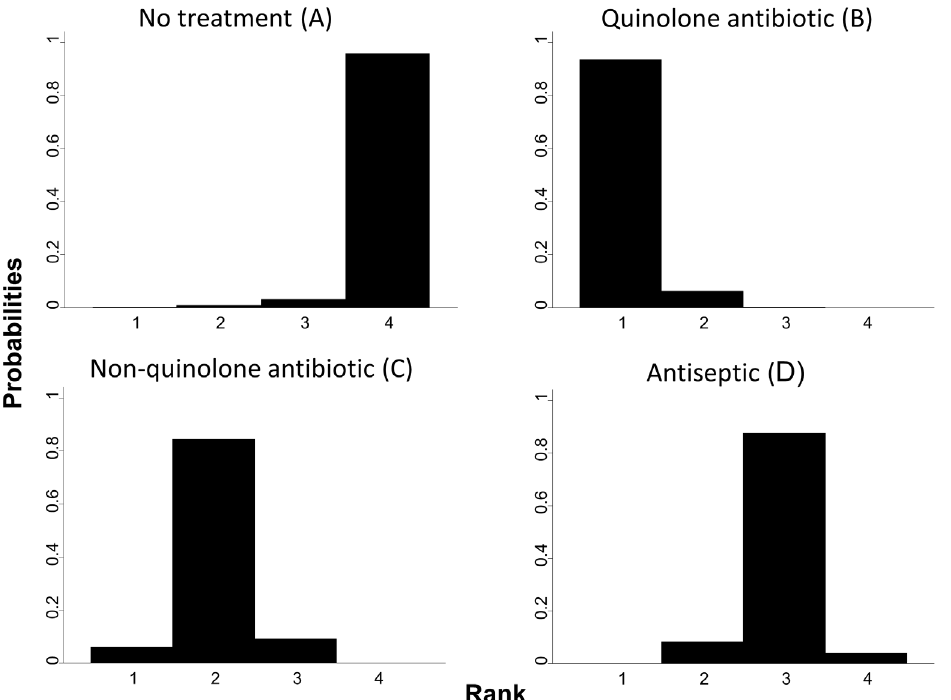
Figure 6. Rankograms for topical antibiotics without steroids for chronically discharging ears. On the horizontal axes are the possible ranks and on the vertical axis the probability that each treatment achieves each rank.